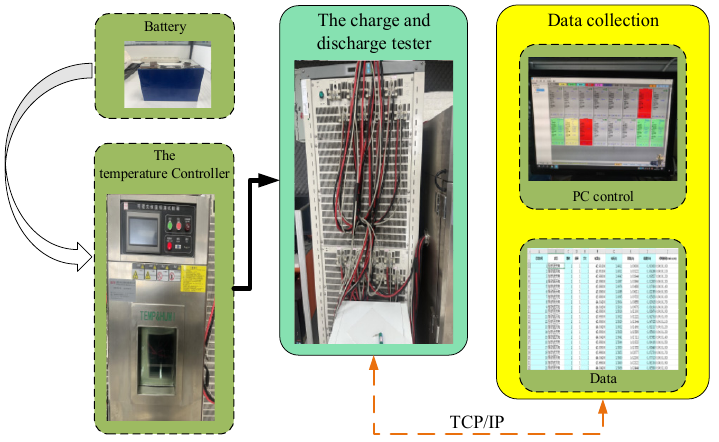
Figure 6. Experimental platform.